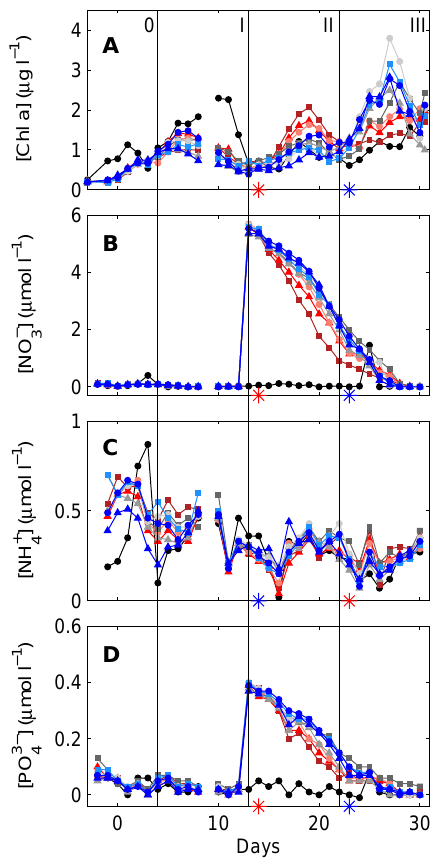
Fig. 6. Temporal development of depth-averaged (0.3–12m) Chl a (A) , nitrate (B) , ammonium (C) and phosphate (D) concentrations in each mesocosm and the fjord. For symbols and colour code, see Table 1. Vertical black lines and Roman numbers illustrate the three phases after CO 2 perturbation while 0 refers to the phase prior to this event. Red and blue stars denote statistically significant posi- tive and negative correlations during a certain phase, respectively. For details on and results of the statistics applied, see Sect. 2.7 and Table 2. Note that statistics for nitrate and phosphate was done on rates, not the actual